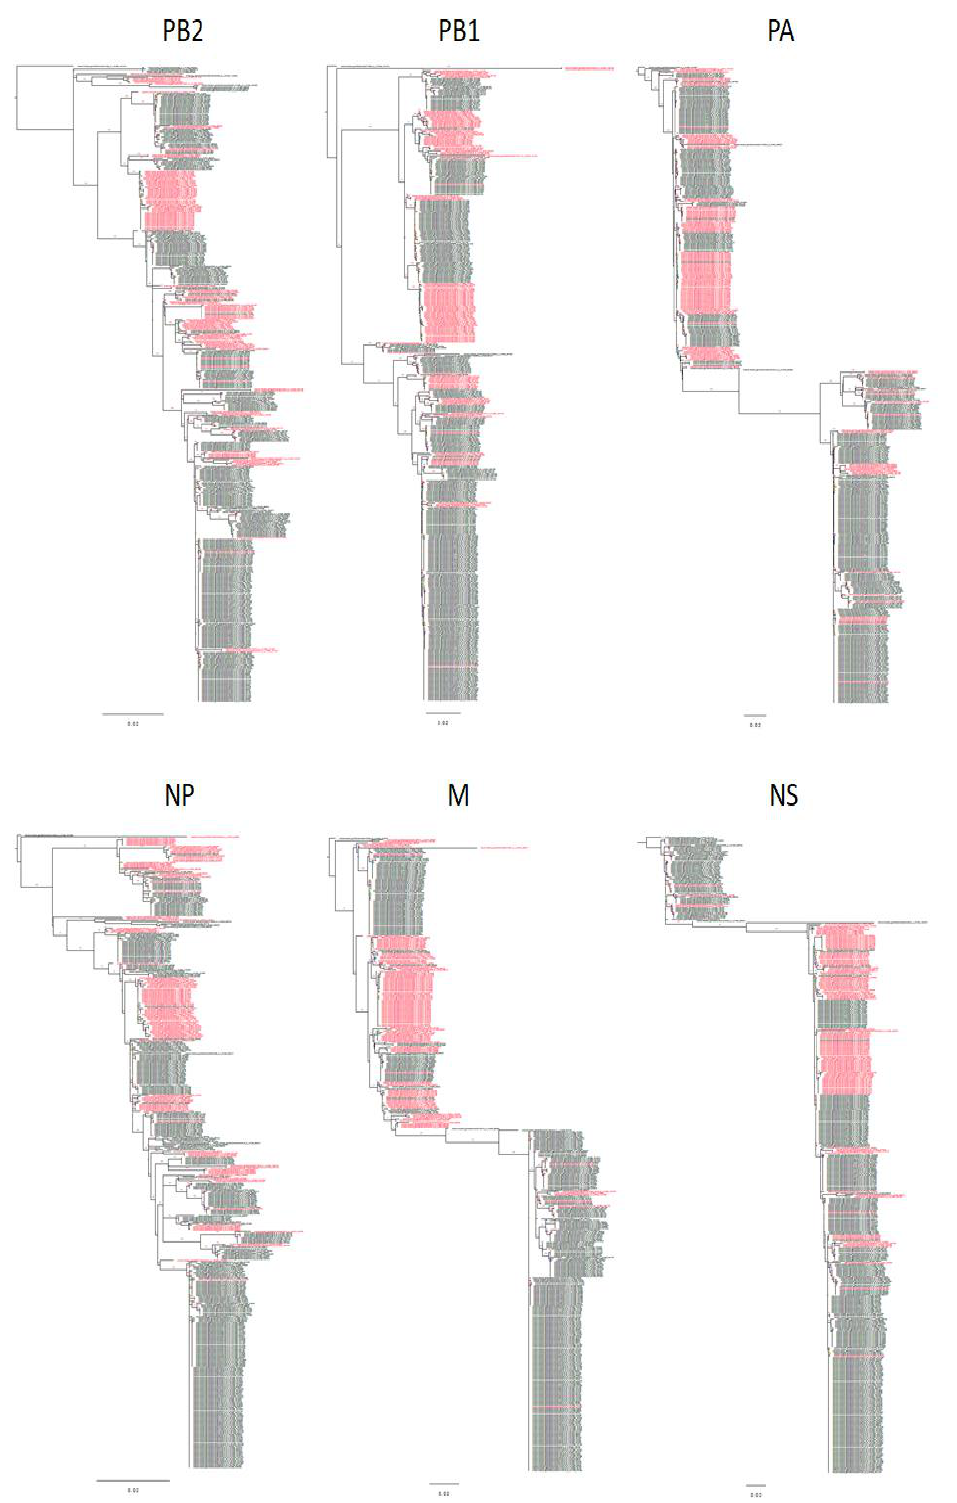
Figure 2. Evolutionary history of six internal gene segments of H13 and H16 AIVs. The trees are based on all published full-length sequences of H13 and H16 gull viruses isolated in The Netherlands. The route is placed on A/Black-headed gull/Netherlands/1/2000 (H13N8). Red color depicts sequences of H16 IAVs. Scale bars, 0.02. The trees were made using FigTree v1.4.4 (http://tree.bio.ed.ac.uk/software/figtree/).